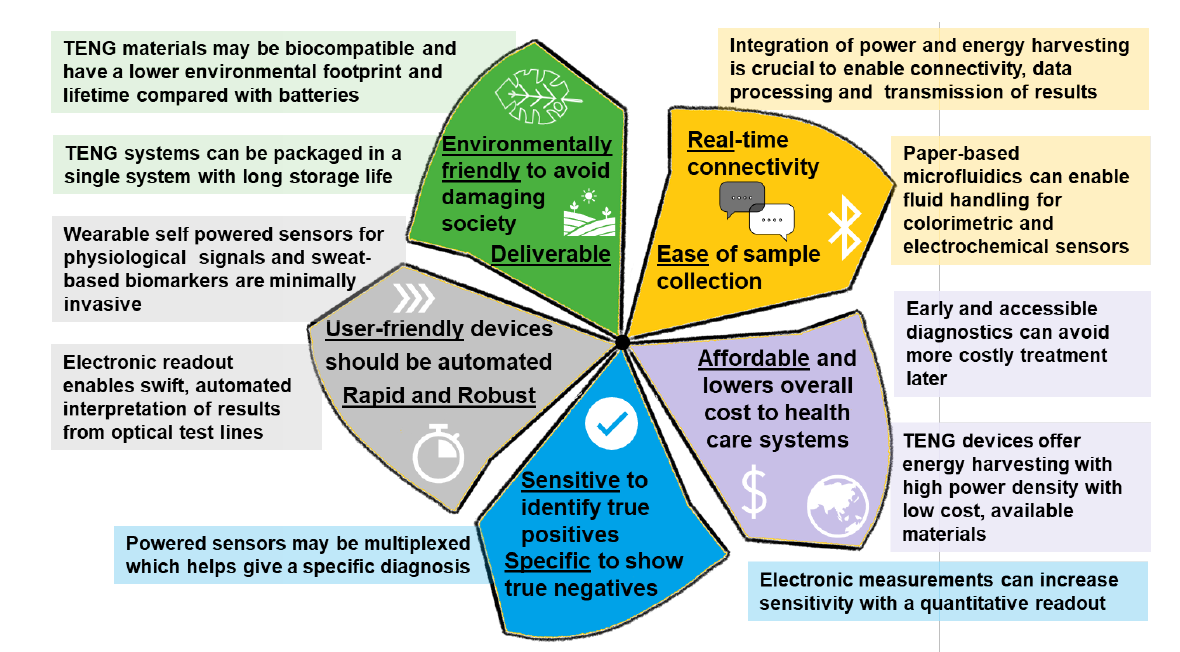
Figure 6. An overview of how Triboelectric Effect Enabled Self-Powered, Point-of-Care Diagnostics can be used to help achieve the REASSURED criteria. Table 2. REASSURED principles and how existing TENG solutions contribute to the fulfillment of these criteria. REASSURED PoC Device